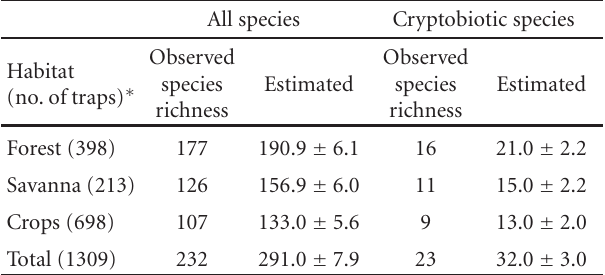
Table 3: Overall ant species richness and richness of cryptobiotic species in three di ff erent habitats. Shown is the observed and esti- mated ( ± SD) number of species (Jacknife1 species richness estima-